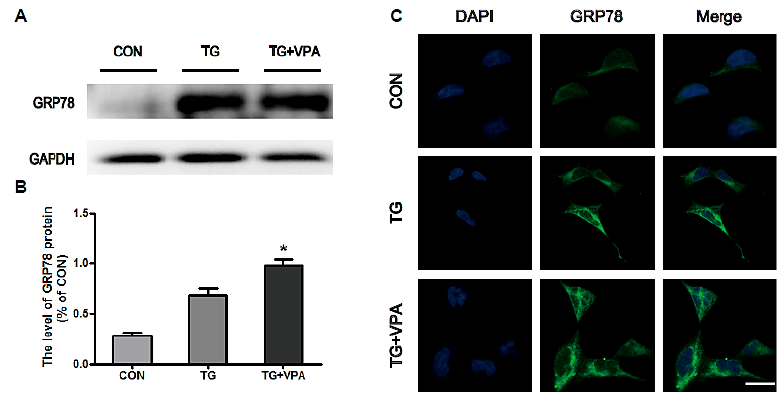
Figure 2. VPA promotes the expression of glucose-regulated protein (GRP78) in SH-SY5Y cells. ( A , B ) The protein level and the optical density of GRP78 in the control, TG, and TG and VPA groups. * p < 0.05 versus the TG group; ( C ) Immunofluorescence of GRP78. The nuclear are labeled by 4 ′ ,6-diamidino-2-phenylindole (DAPI) ( blue ), the target proteins (GRP78) are labeled by GFP-tagged proteins ( green ). Magnification was 40×. Data are the mean values ± SEM, n = 3.